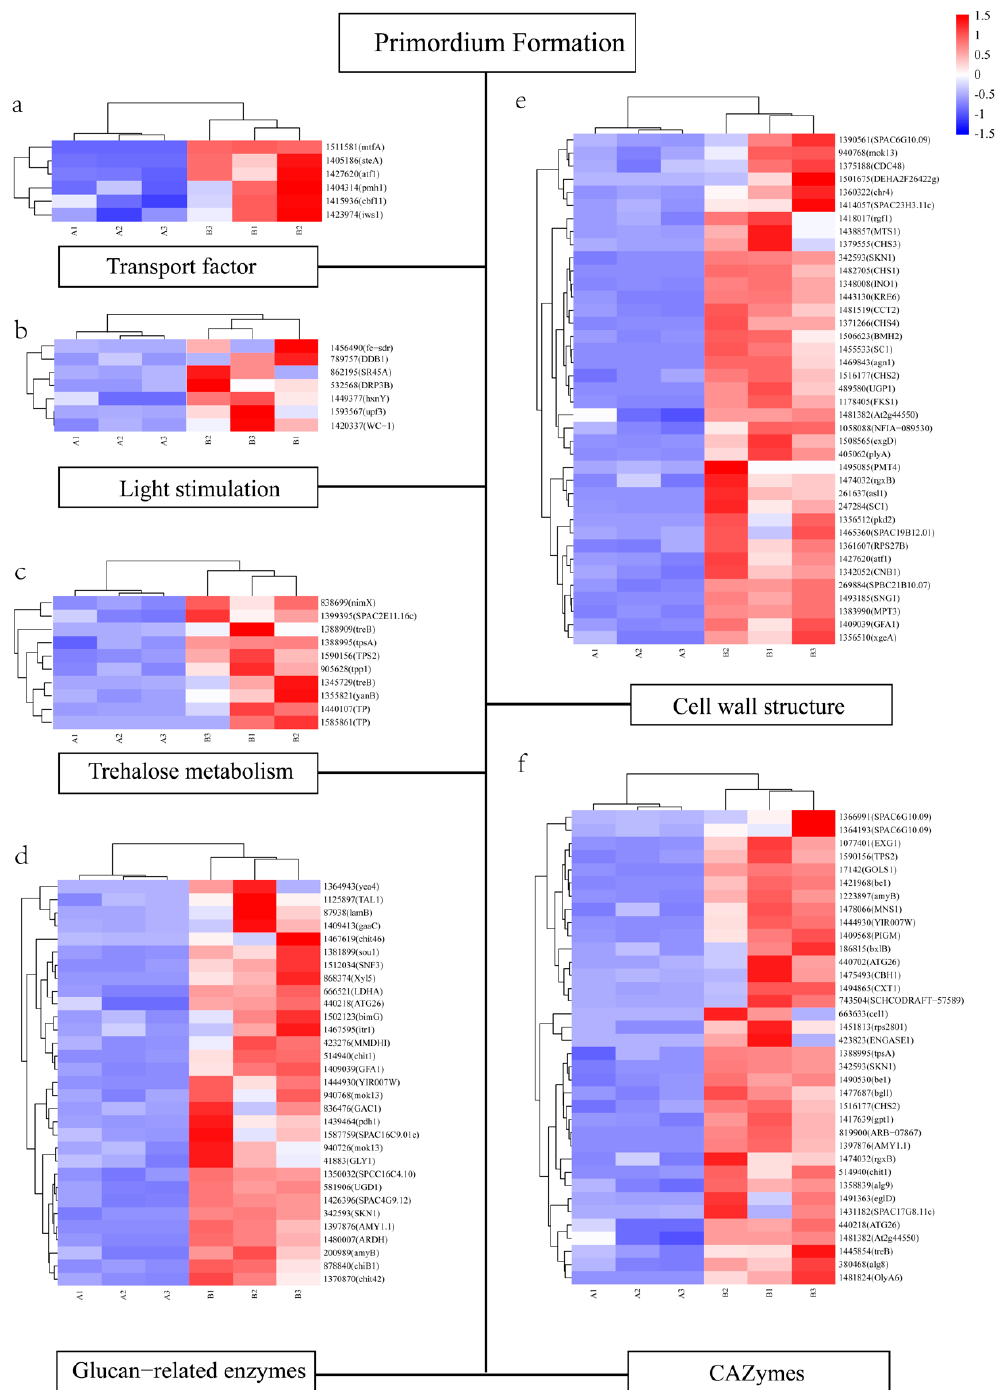
Figure 5. Genes involved in primordium formation of P. eryngii . ( a ) Transcription factors. ( b ) DEGs related to light stimulation. ( c ) DEGs related to trehalose metabolism. ( d ) DEGs related to glucan-related enzymes. ( e ) DEGs related to cell wall structure. ( f ) DEGs related to CAZymes. The right side of the heat map indicates the transcript ID in P. eryngii , the annotation gene name, and the bottom of the heat map notes the samples. A means mycelium, B means primordium. The gene expression values (FPKMs) were transformed to Z-score values.